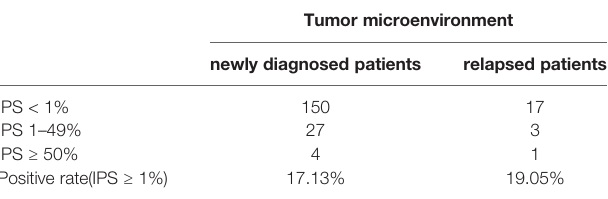
TABLE 1-2 | The number and positive rate of tumor microenvironment PD-L2 in newly diagnosed and recurrent diffuse large B-cell lymphoma patients. Tumor